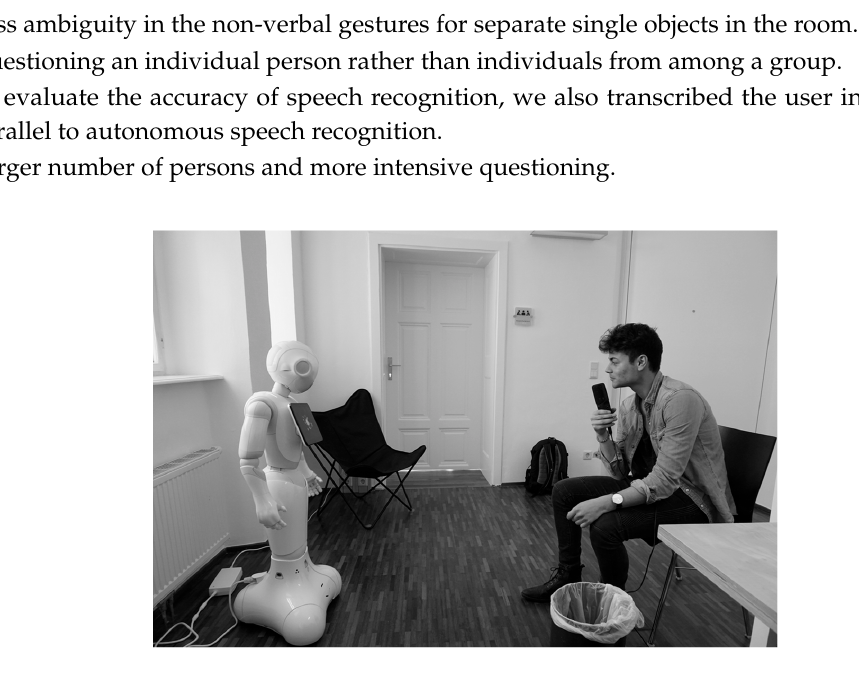
Figure 4. Floor plan of the experimental area with location of the five objects, translated into English, the robot (R) and the interview partner (P). Naming of object, function attributed to object, property associated to function and object. Bars indicate how often names and functions were mentioned.